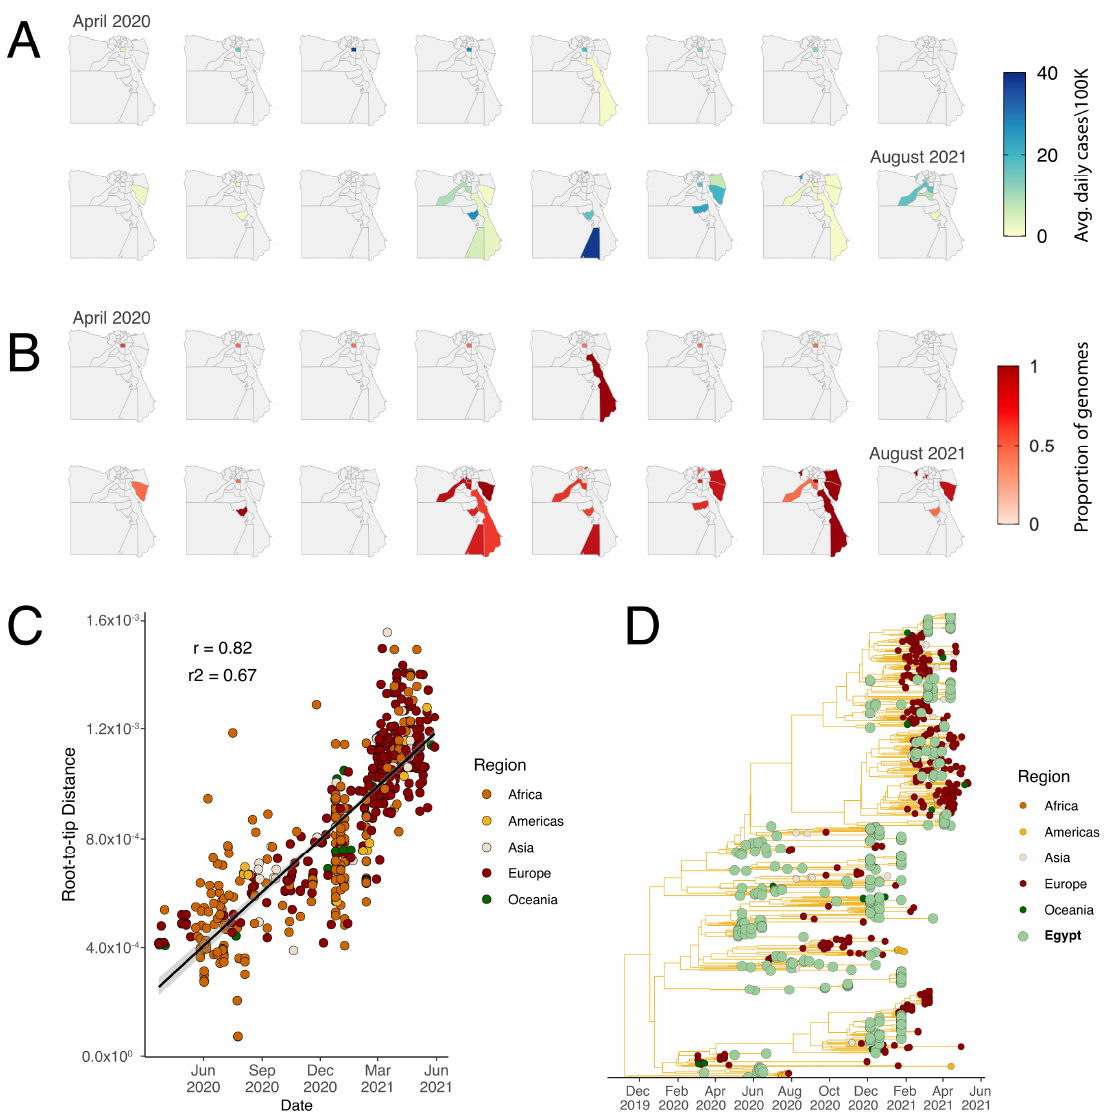
Figure 3. Average daily cases and distribution of the C.36 lineages in Egypt over time, and root-to- regression and phylogenetic placement of the Egypt C.36 genomes in the context of global C.36 sequences. ( A ) Prevalence maps following the progression in the daily number of cases, and ( B ) Proportions of C.36.3 lineage samples per governorate in Egypt confirmed by RT-PCR from April 2020 to July 2021. ( C ) Root-to-tip regression plot of the C.36 lineages. ( D ) Maximum clade credibility phylogenetic tree including all the global sequences of the C.36 lineages.